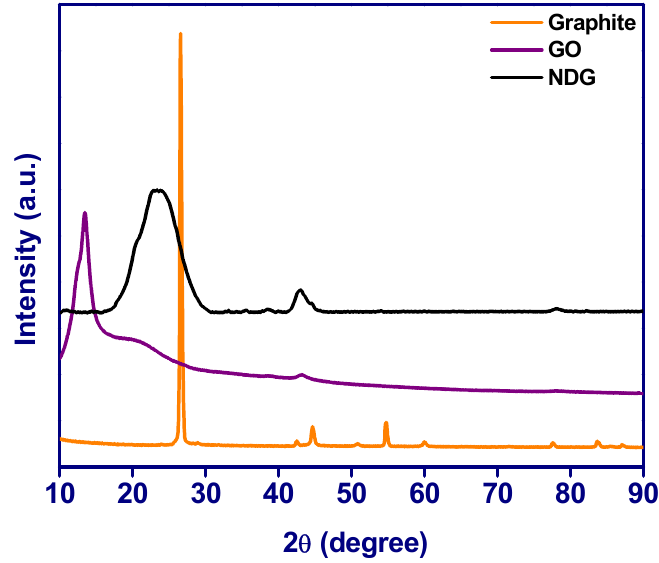
Figure 3. XRD pattern of graphite, GO, and NDG.